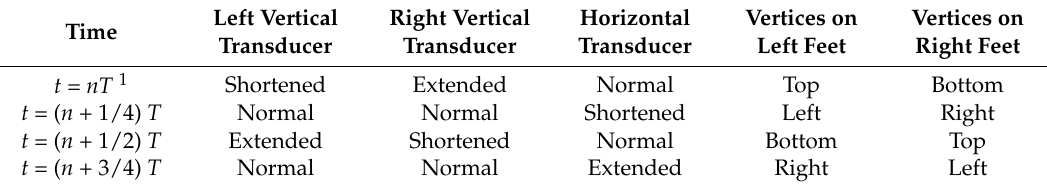
Table 1. The vibration statuses of the transducers in one period.